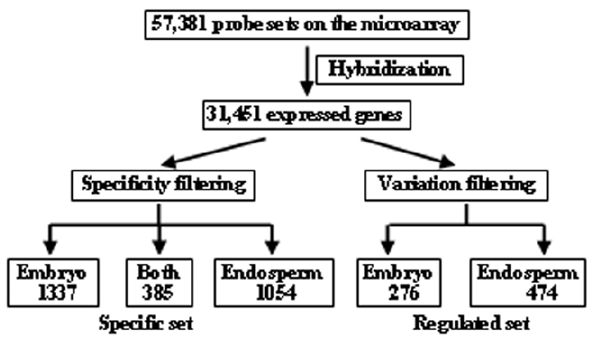
Figure 1. Analysis approaches of gene expression patterns in rice developing seeds. Work flow of data analysis was shown, genes of specific set and regulated set were analyzed respectively (See Materials and Methods